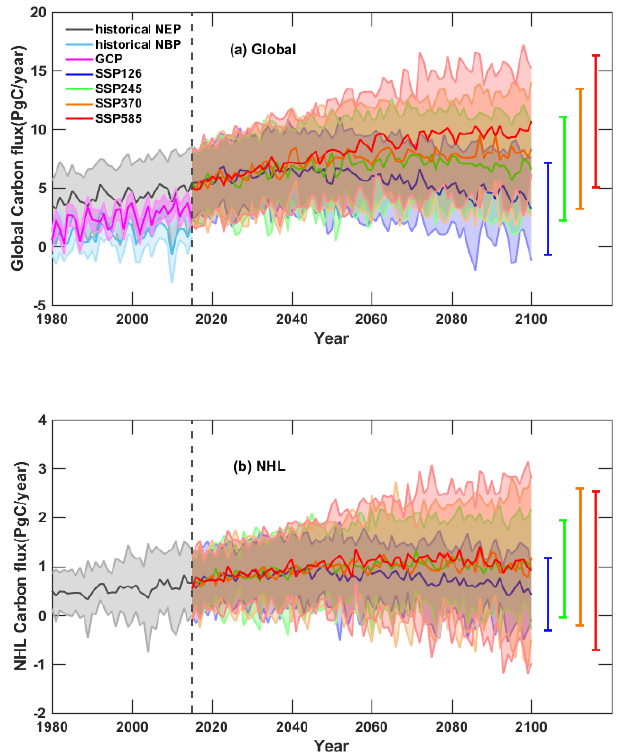
Figure 1. The annual mean and SD of NEP of the 10 CMIP6 mod- els during the historical period (1980–2014) and the future period (2015–2100) under four global change scenarios at the global (a) and northern-high-latitude (NHL) (b) scales. The shaded area indi- cates the SD values across the models. Error bars at the right of the panels show the mean SD of NEPs during 2095–2100 under each of the four